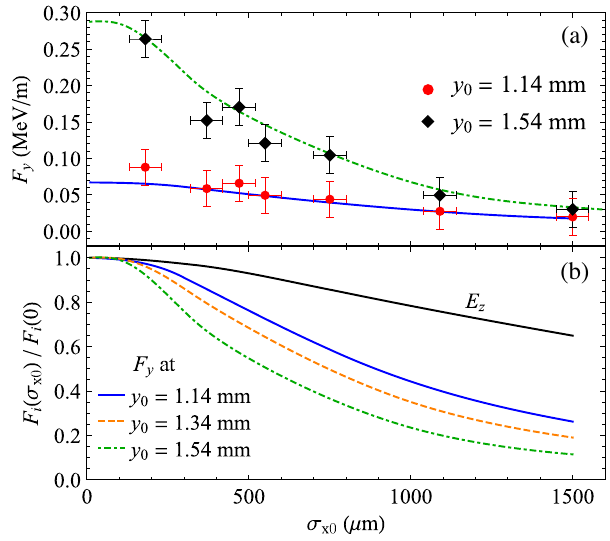
FIG. 7. (a) Average transverse F y wakefield strengths as a function of σ x 0 . F y is measured with a structure half-gap of ¼ 1 . 14 and 1.54 mm. rms bunch a ¼ 2 . 0 mm, and offsets y 0 length is set to 800 fs. Lines — corresponding simulation results. (b) Normalized simulated dependencies of E z and F y on σ x 0 from Figs. 6 and 7(a).